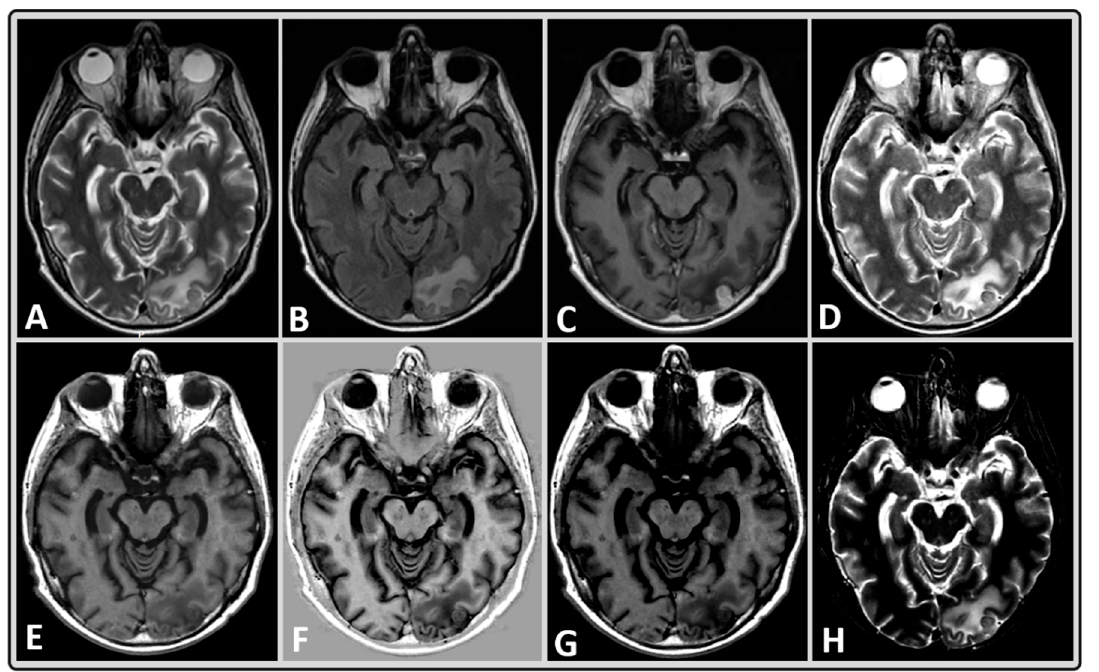
Figure 2. Representative MRI data of a 40-year-old male BM patient treated with whole-brain RT using standard and synthetically-generated (MAGiC) images. ( A – C ) T2w, T2w fluid attenuated inversion recovery (FLAIR) and T1w post-contrast images, respectively, from standard clinical imaging. ( D – H ) T2w, T1w, phase-sensitive inversion recovery (PSIR), T1w FLAIR, and short tau inversion recovery (STIR) images, respectively, from MAGiC.